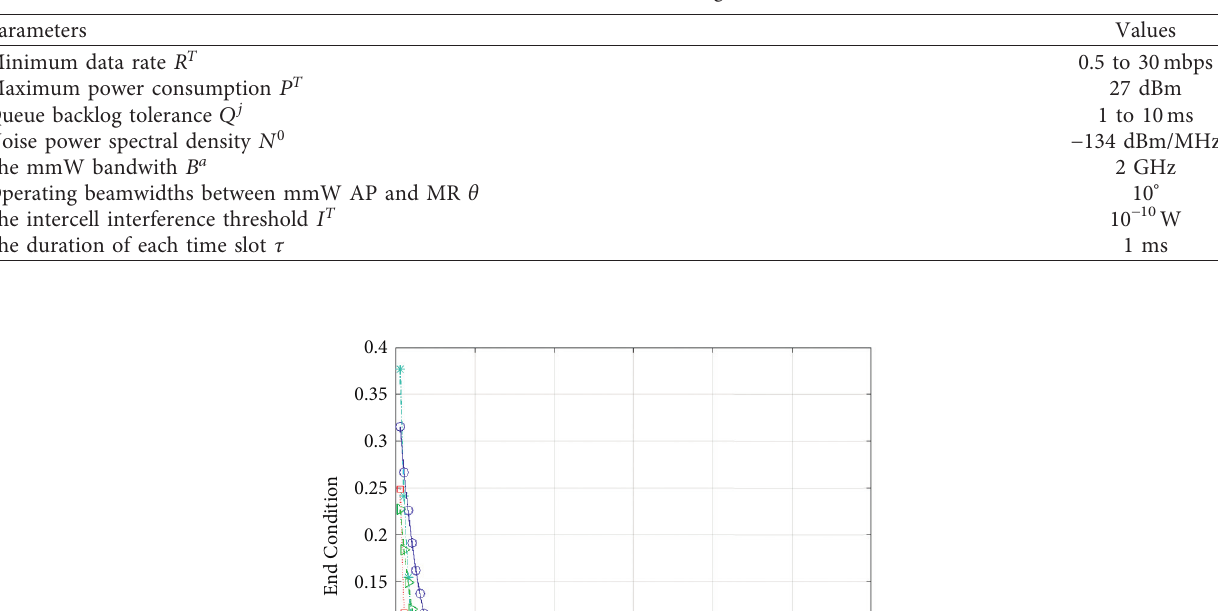
Table 1: Parameter setting.